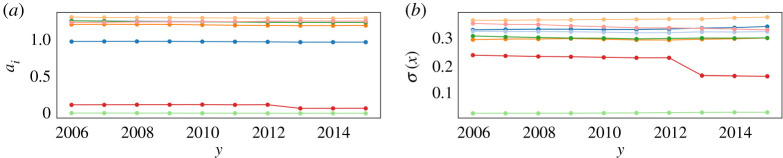
(a) Scaling exponents ai for the socio-economic indicators i as a function of time. (b) σ(xi) for the socio-economic indicators i as a function of time. Each indicator is represented by a different colour.